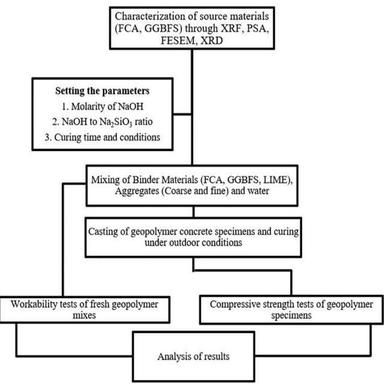
Flowchart for experimental procedure of the current work.